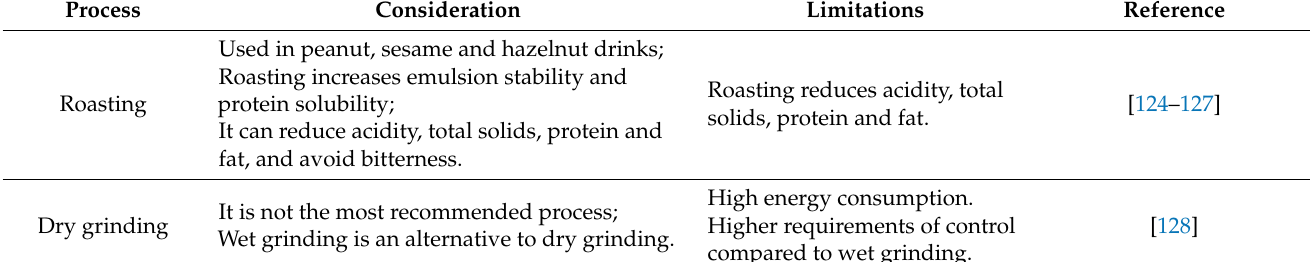
Table 5. Production stages of plant-based drinks. Adapted from